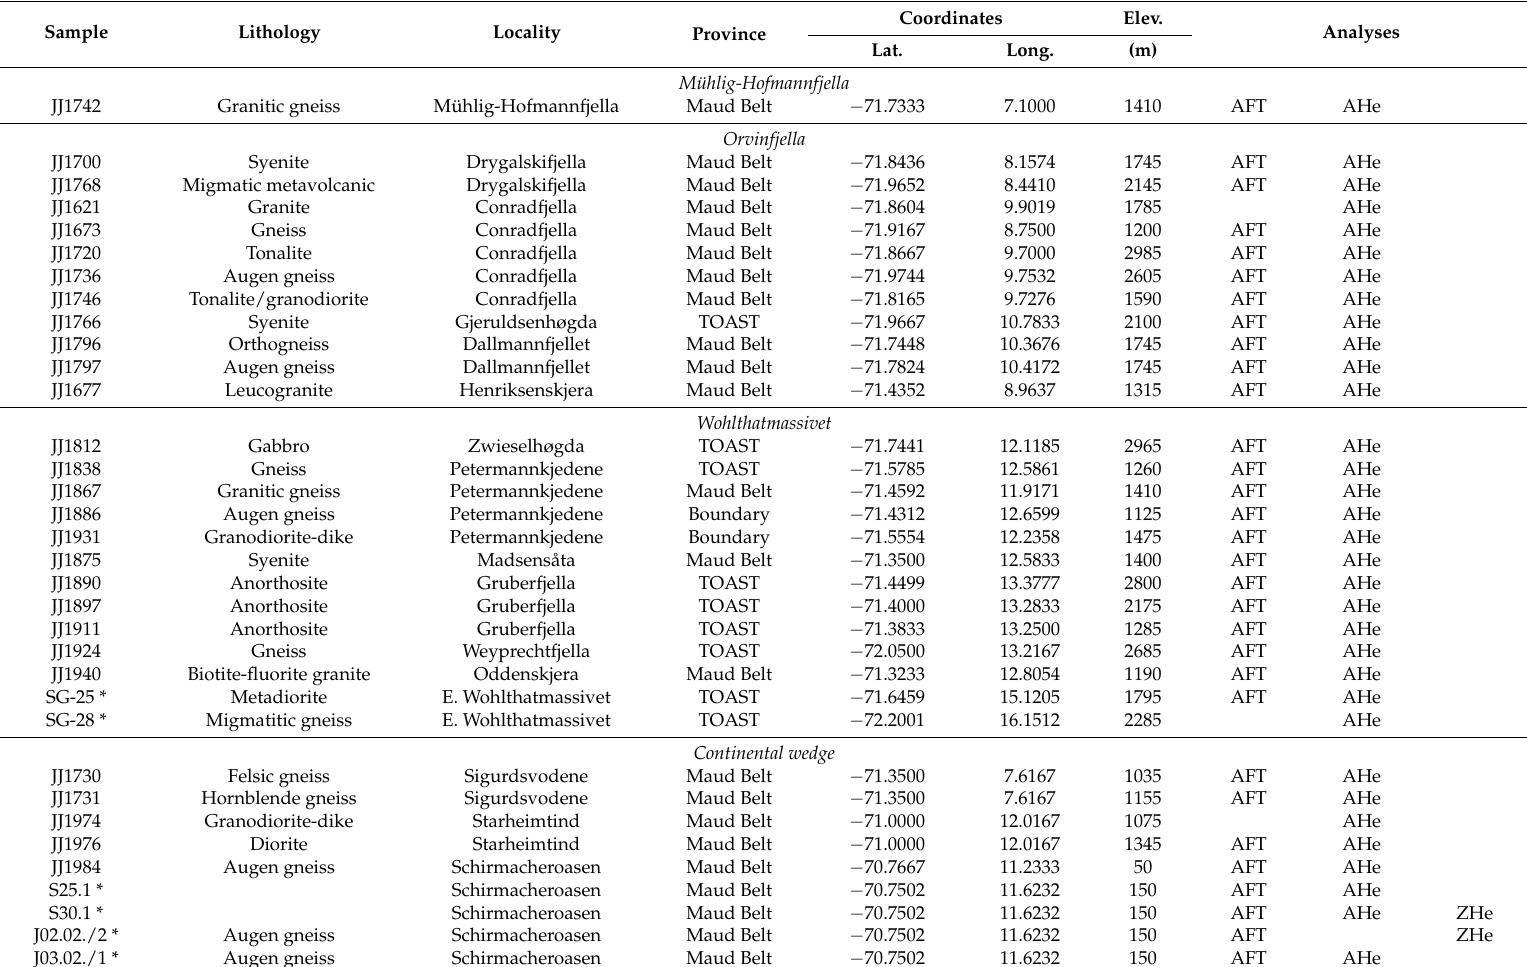
Table 1. List of samples used in the present